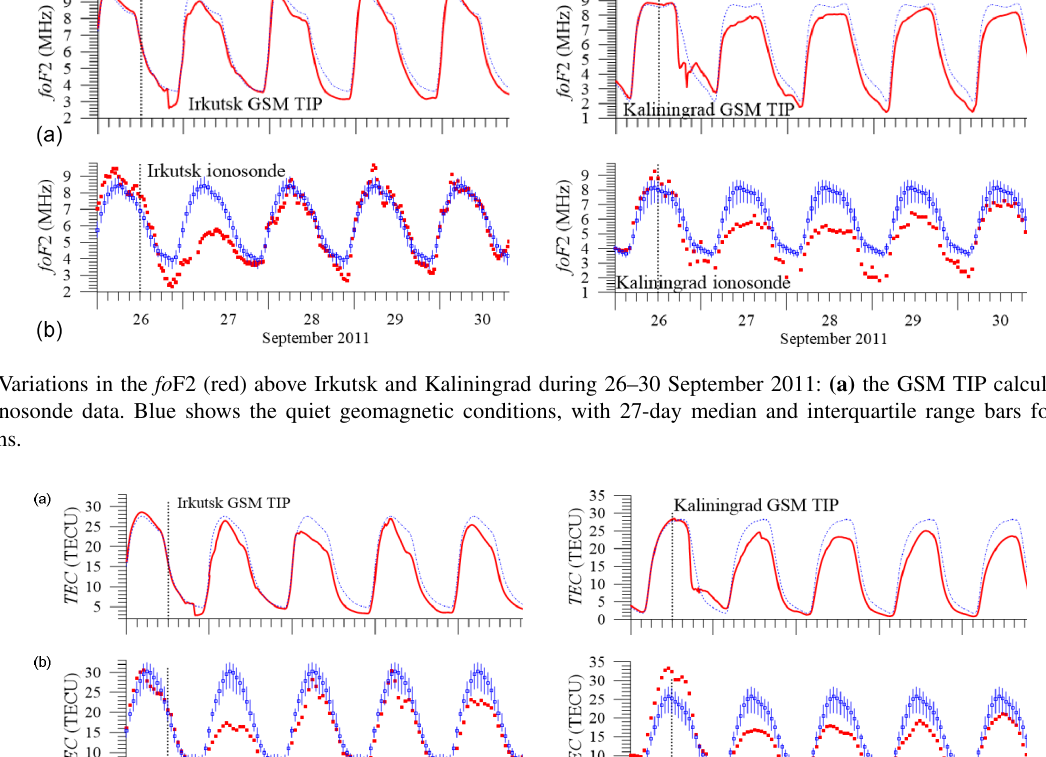
only negative fo F2 disturbances over Kaliningrad during